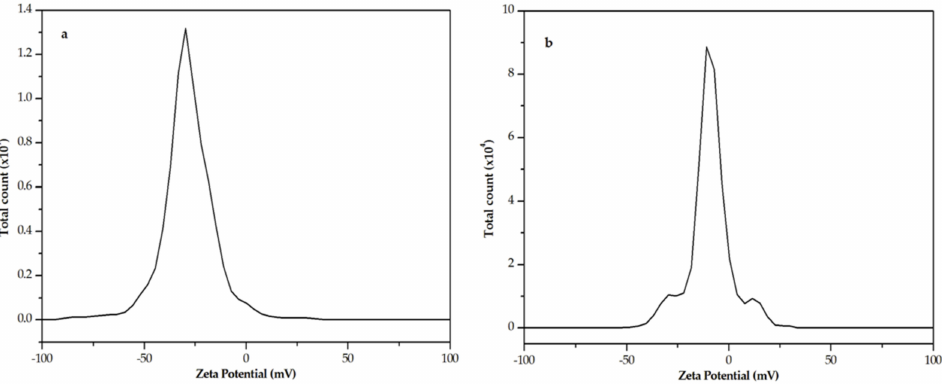
Figure 3. Zeta Potential of HGAm ( a ) and GAm ( b ) in water.